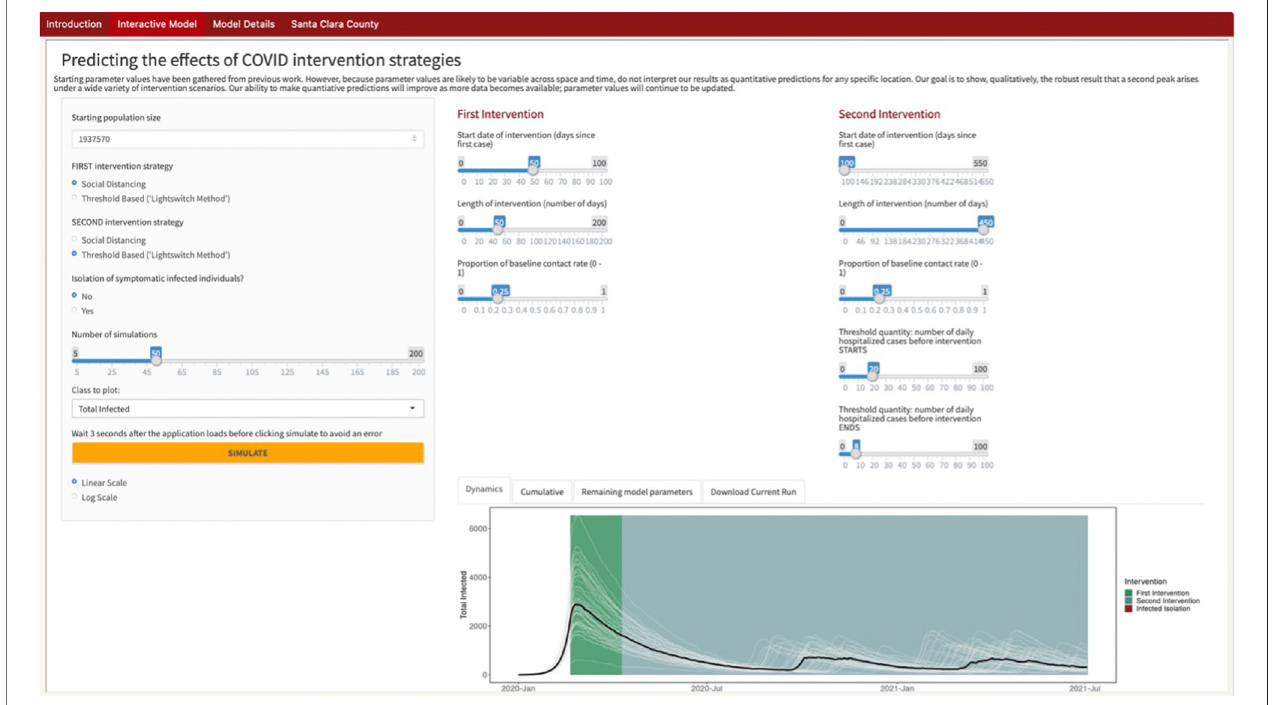
FIGURE 9 | Interactive model for predicting effect of Covid-19 Intervention strategies (Childs et al., 2020).